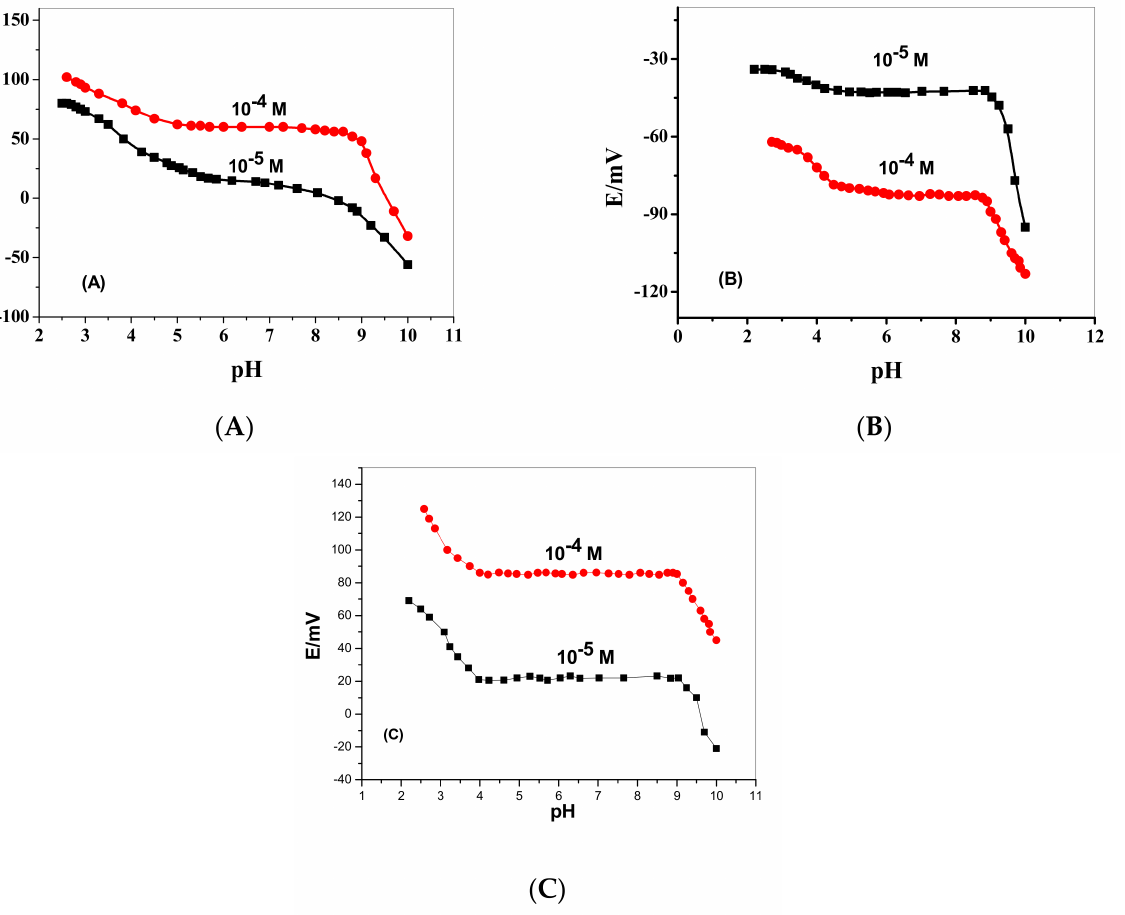
Figure 2. pH-potential profiles for FLX membrane sensors plasticized in o, NPOE ( A ) ionophore I; ( B ) ionophore II and ( C ) ionophore